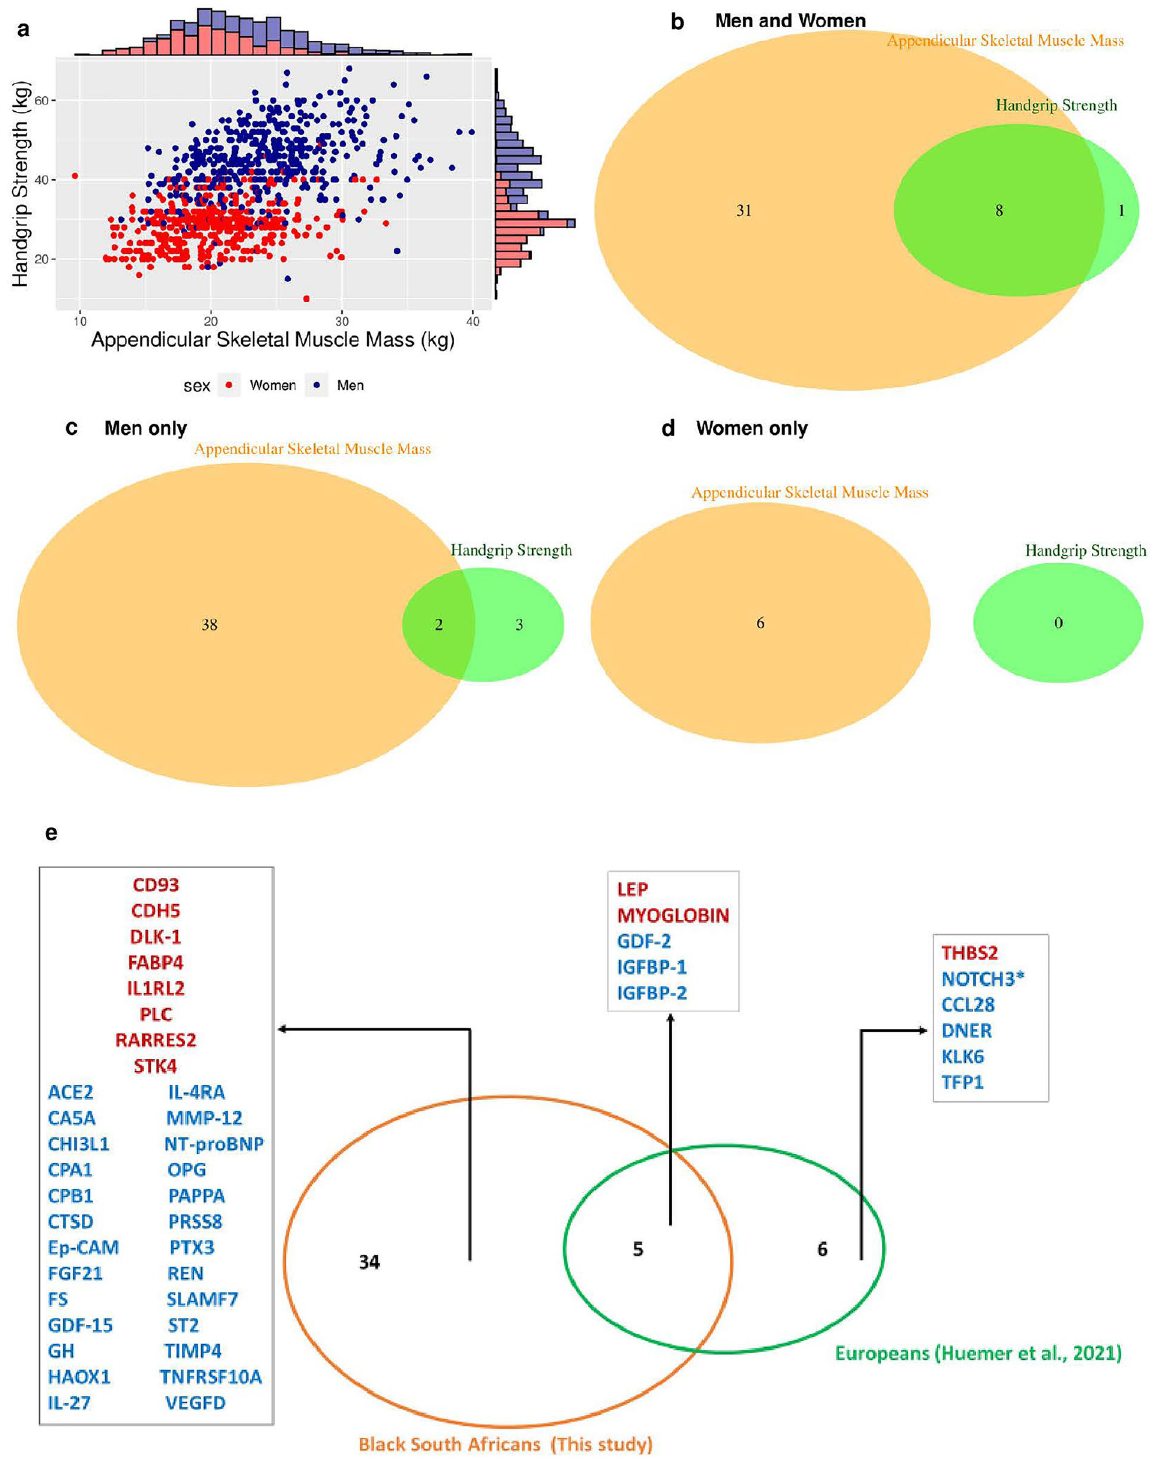
Figure 7. Relationship between ASM and HGS and biomarker comparison with European findings 19 . Biomarkers in red were associated with higher ASM and biomarkers in blue were associated with lower ASM. *Associated with lower ASM in Europeans but with higher ASM in black South African men only ( e